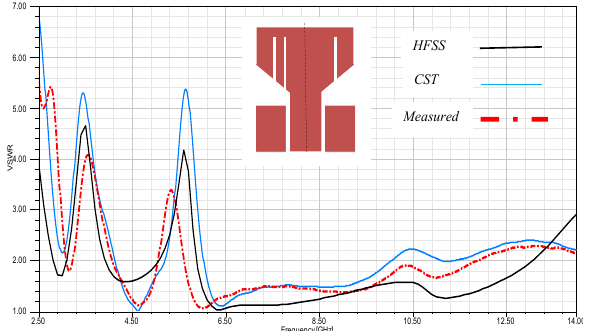
Figure 11: Measured VSWR with simulation results.